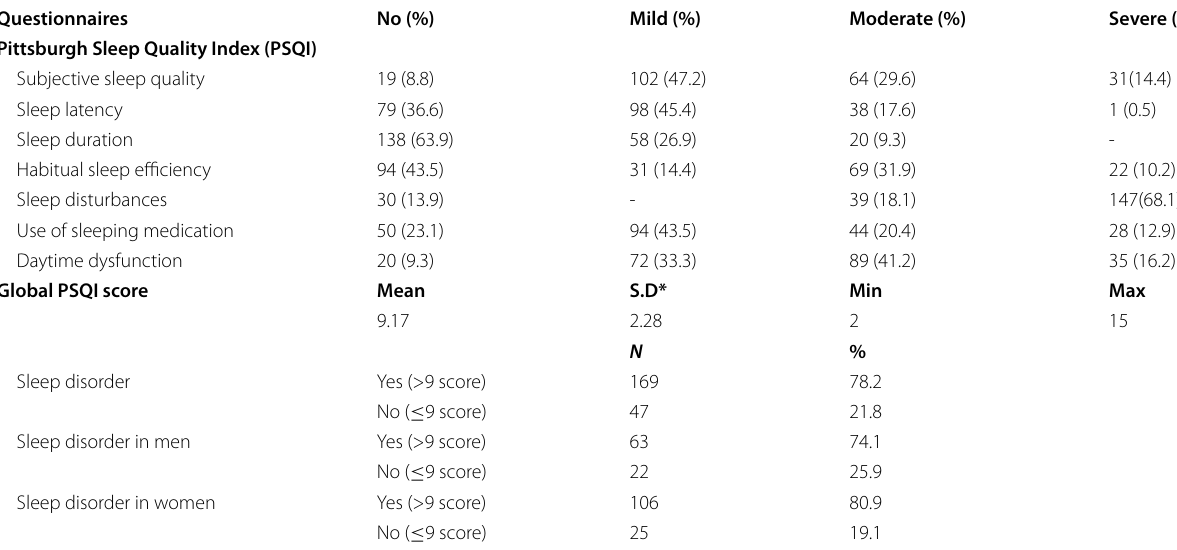
Table 3 Distribution of the Pittsburgh Sleep Quality Index (PSQI) and its scales in the workers under study